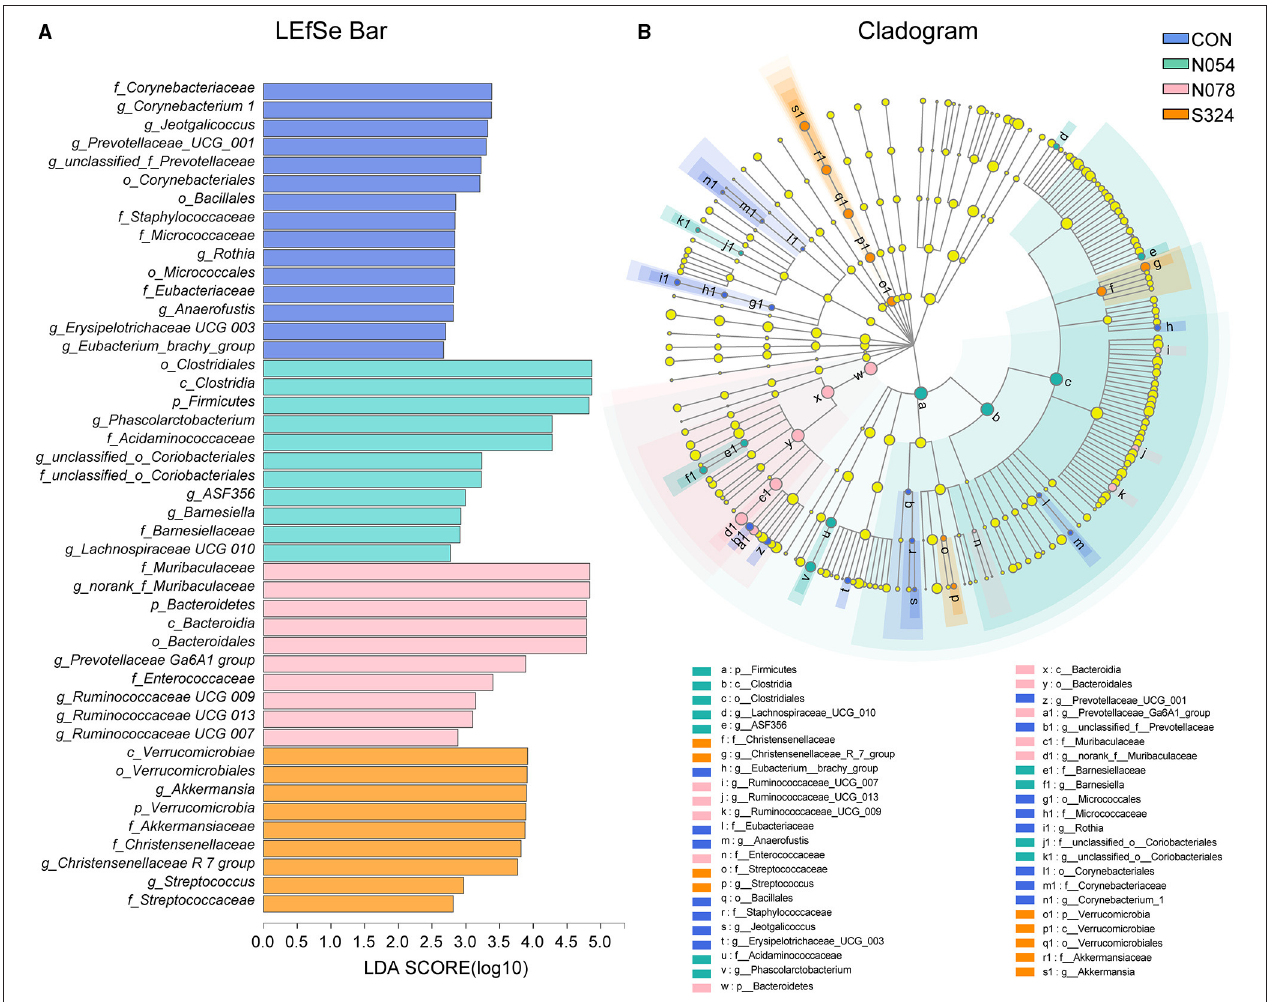
FIGURE 3 | LDA effect size (LEfSe) analysis based on genus level among four groups. (A) LEfSe bar plot demonstrating the significant bacterial differences. (B) Cladogram indicating the phylogenetic distribution of fecal microbiota with phyla in the outermost and genera in the innermost ring. Multiple comparison strategy was all-against-all ( n = 6). Only LDA score > 2.0 is